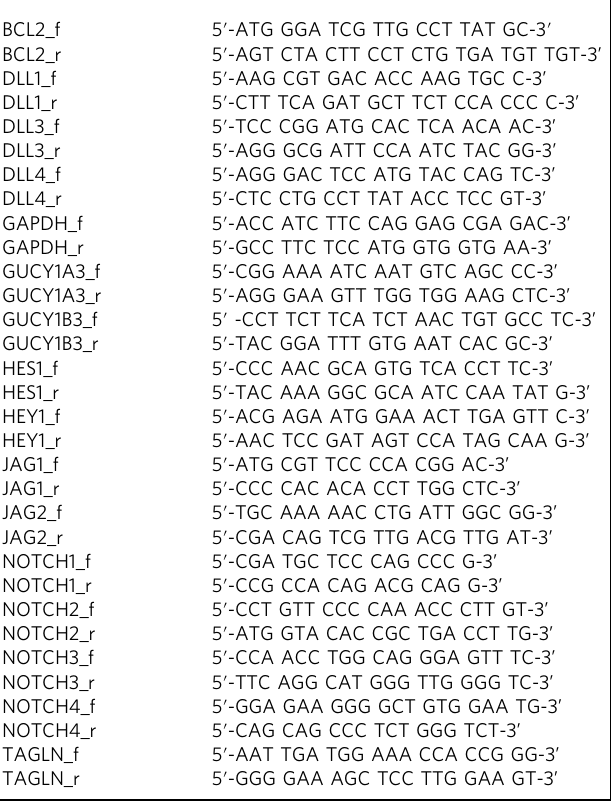
Table 2 List of qPCR primers used in this